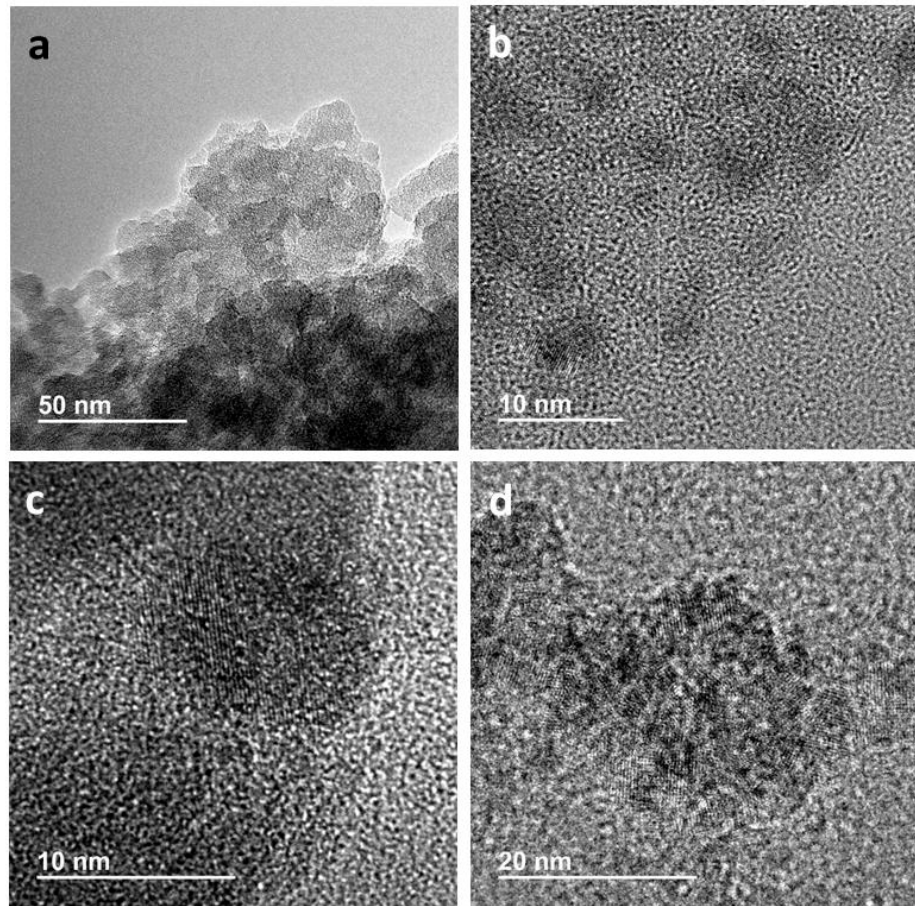
Figure 2. TEM images of selected catalysts. ( a ) TEM and ( b ) HRTEM micrographs of the Pd NPs-UVM-7/PDA- 1 catalyst. HRTEM images of the Pd NPs-UVM-7/PDA- 2 ( c ) and Pd NPs-UVM-7/PDA- 5 ( d ) catalysts.